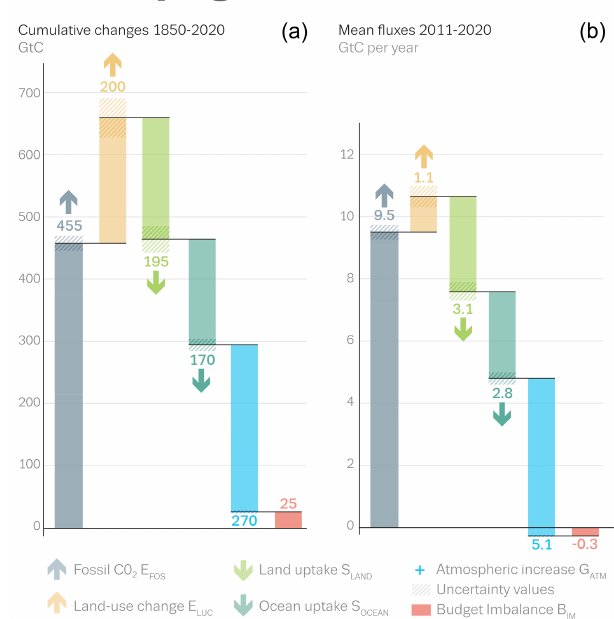
Figure 13. Cumulative changes over the 1850–2020 period (a) and average fluxes over the 2011–2020 period (b) for the anthropogenic perturbation of the global carbon cycle. See the caption of Fig. 3 for key information and the methods in text for full